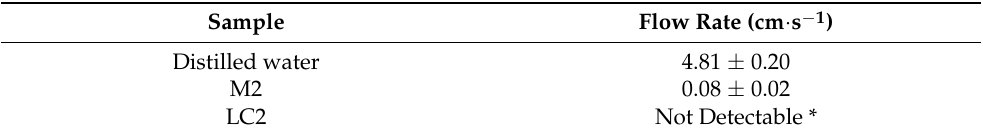
Table 8. Flow rate of water-in-oil (W/O) ME (M2) and LC (LC2) along a hardened gel simulant surface tension of tear fluid.